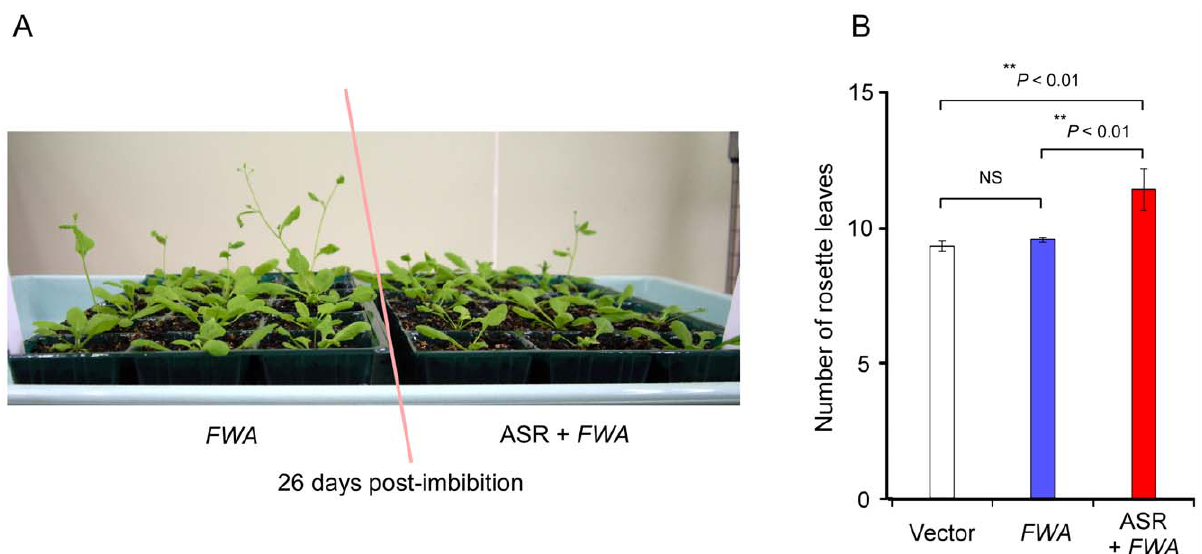
Figure 3. Silencing of the FWA transgene and its prevention by ASR602 in Arabidopsis (Col-0). ( A ) FWA -transformed plants ( FWA ) and plants transformed with an ASR602-fused FWA (ASR + FWA ). ( B ) Flowering time in FWA transformants and control transformants (Vector: plants transformed with vector only). Late flowering increases the number of rosette leaves. Vector, n=11; FWA , n=117; ASR + FWA , n=14; n, number of independent transformants. Mean values are given. Error bars denote 6 s.e.m. ** P , 0.01; NS , not significant.